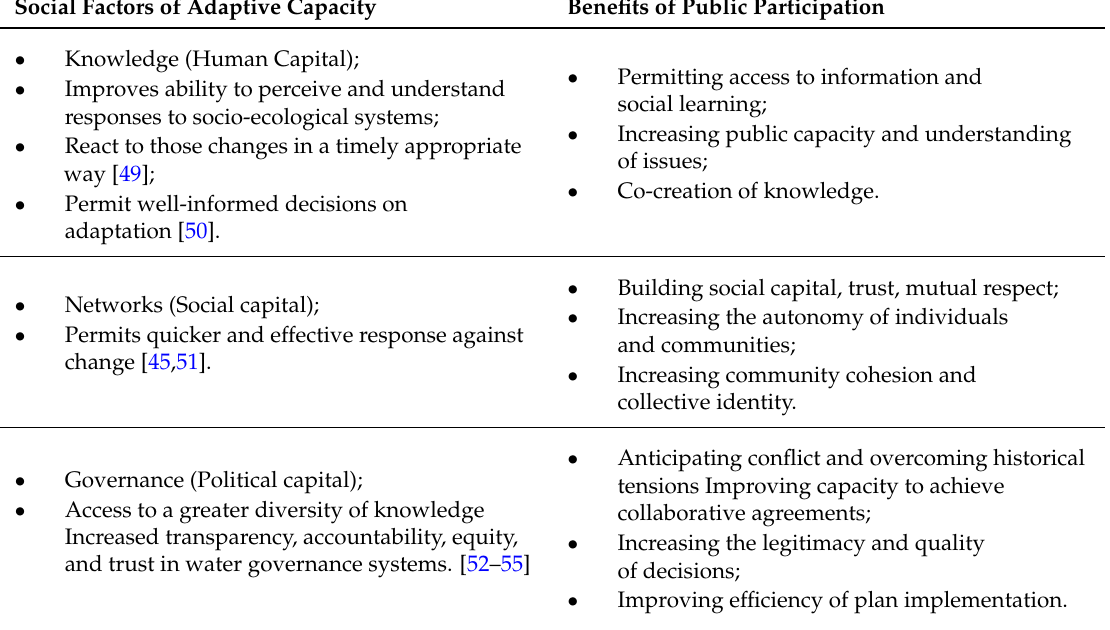
Table 2. Relationship between social factors of adaptive capacity and benefits of public